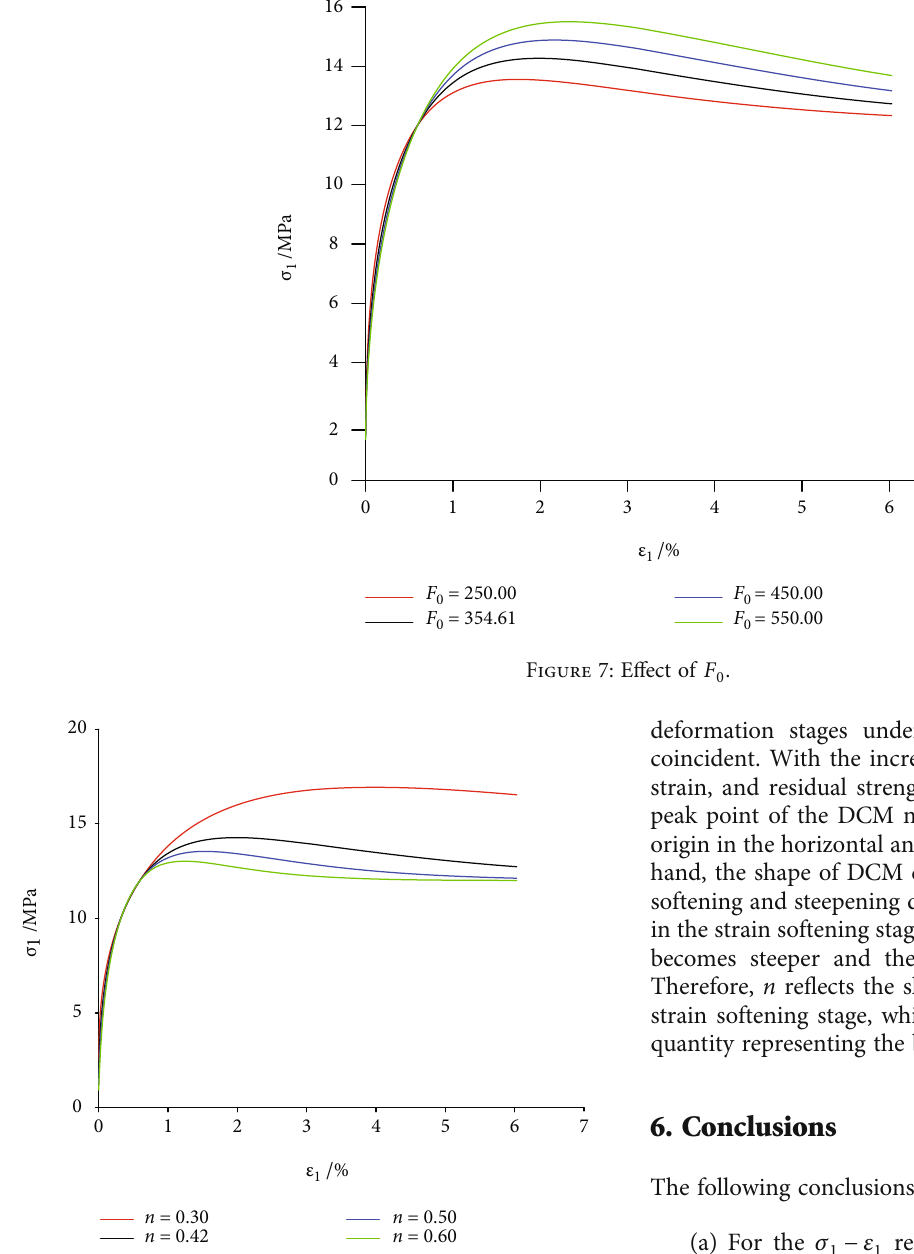
Figure 8: E ff ect of n